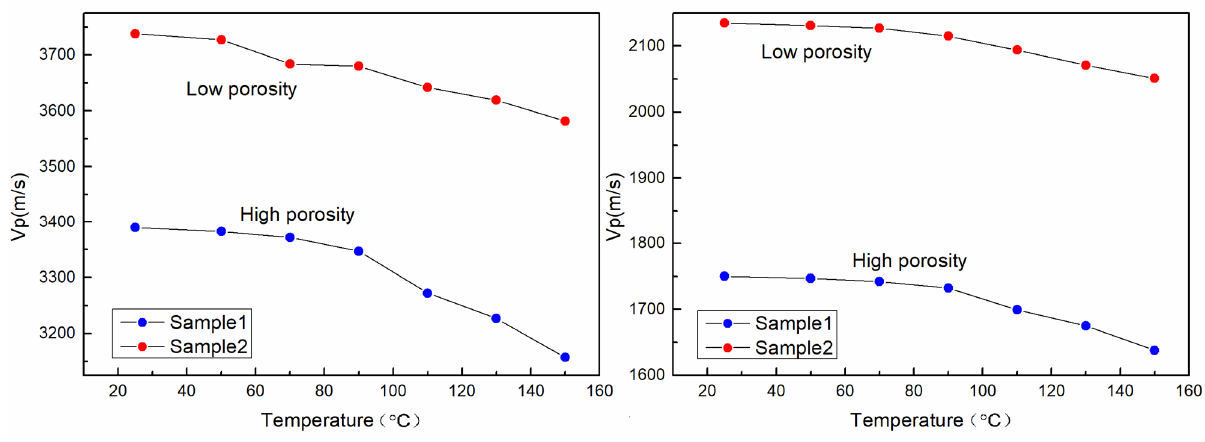
Figure 7. The thin section images of ( a ) Sample 1 and ( b ) Sample 2.